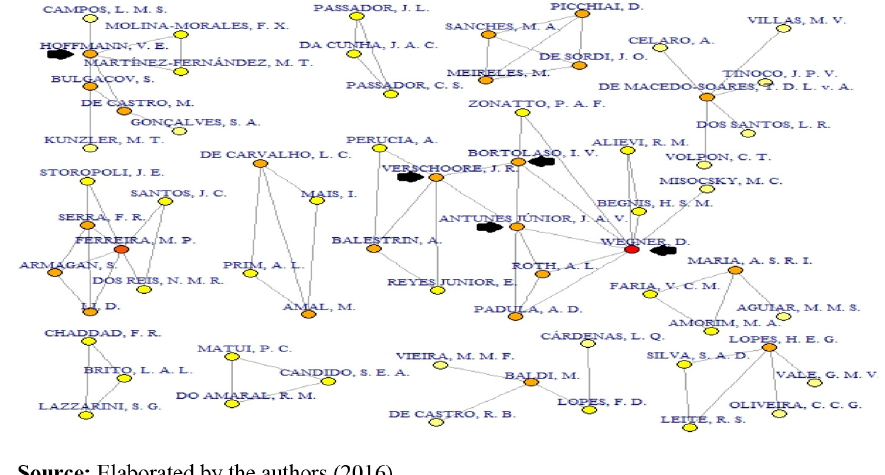
Figure 6. Centrality of the network with intermediation